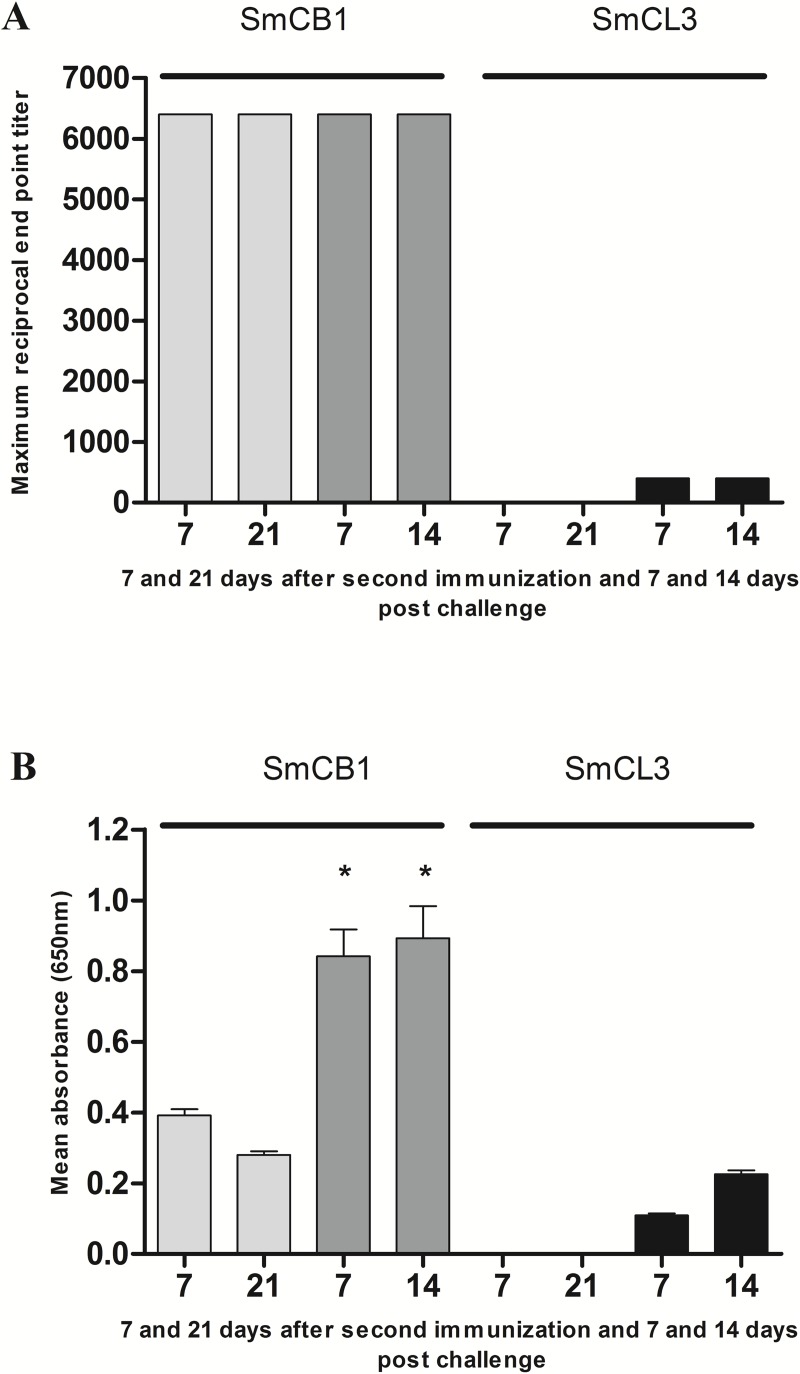
Serum antibody response to SmCB1 and SmCL3 following immunization and challenge infection of mice.(A) Serum antibody reactivity to SmCB1 and SmCL3 was assessed by ELISA at 7 and 21 days after second immunization and 7 and 14 days following challenge infection with 150 cercariae of S. mansoni. (B) Antibody reactivity at 7 and 21 days after second immunization and 7 and 14 days after the challenge infection were compared at dilutions of 1:200 with each column denoting mean value for three mice +/- SD; asterisks indicate significance (* P < 0.05) of differences.